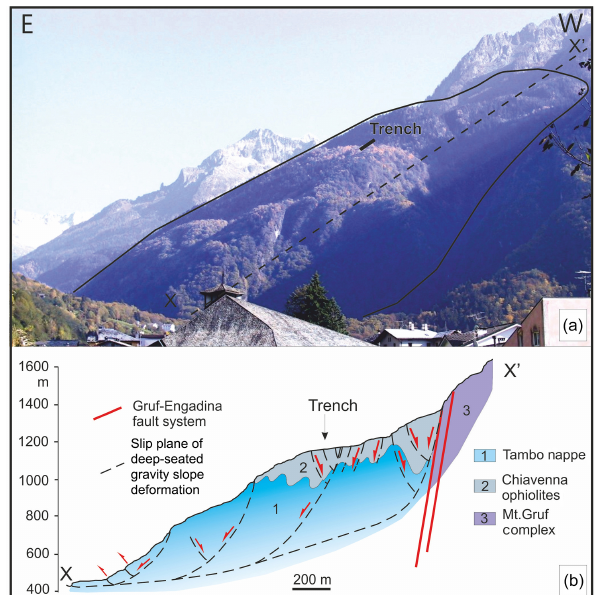
Figure 7. (a) Photo of the Bregaglia Valley DSGSD (central Alps, Italy) studied by palaeoseismological techniques and location of the artificial trench. The DSGSD is subdivided into four main blocks by three slip planes steeply dipping toward the valley floor. Arrows in- dicate the relative block movements. (b) Geological-structural sec- tion across the DSGSD. The location of the artificial trench of Fig. 8 is shown. Trace X–X’ of the section in Fig. 7a (modified after Tibaldi and Pasquaré,